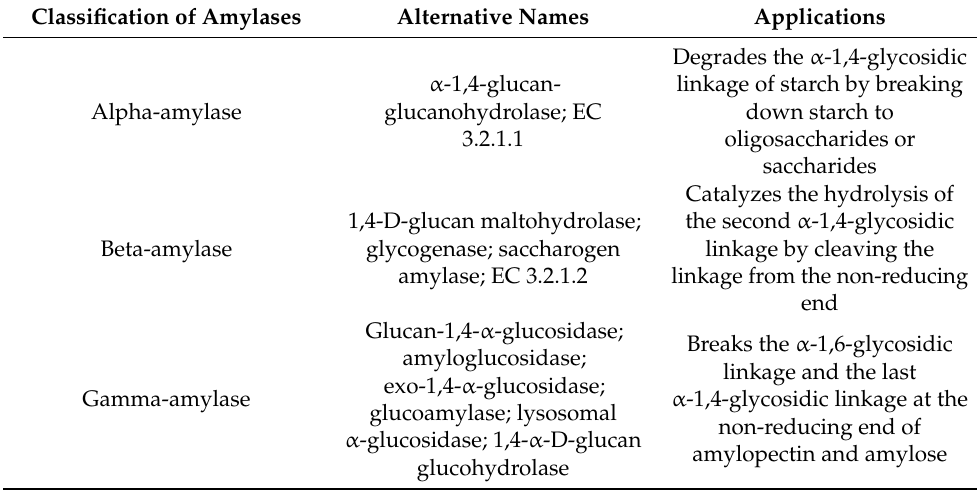
Table 1. The classification of amylases and their applications. Classification of Amylases Alternative Names